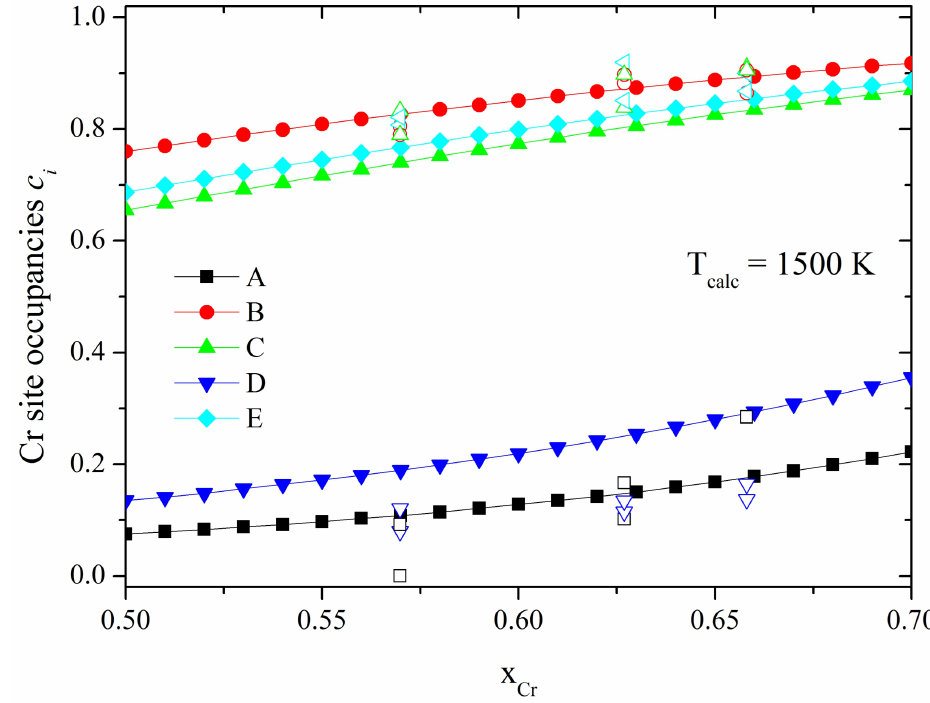
Figure 4. The Cr site occupancies of the (A, B, C, D, E) sublattices in the Co-Cr system versus the Cr composition, x , at fixed T = 1,500 K. The full symbols denote the calculated Cr results, the empty symbols represent the experimental site occupancies (error bars are less than 0.5%)